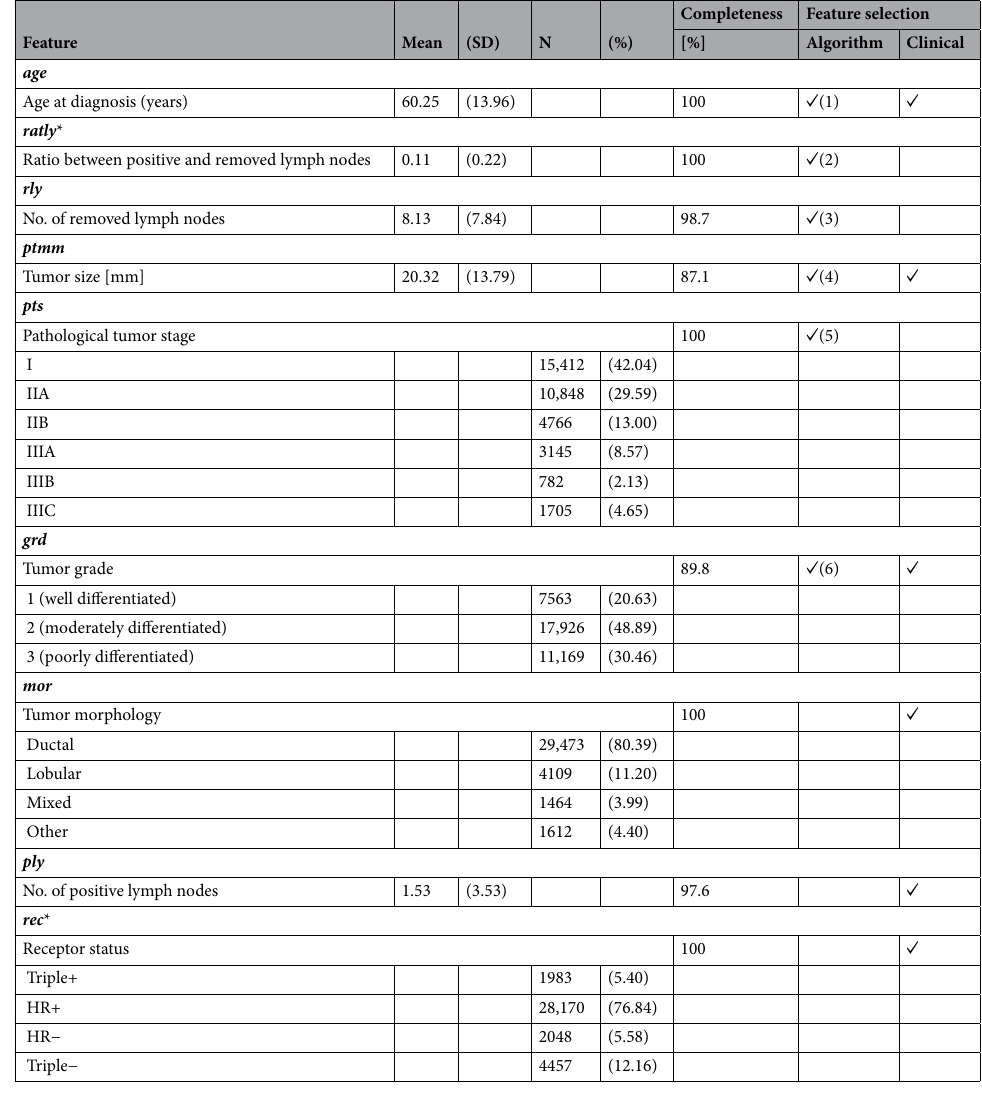
Table 1. General overview of the data used for this study. Features marked with an asterisk were engineered (see text for more details). The number in parenthesis in the Algorithm column corresponds to the feature’s ranking given by the feature selection. SD standard deviation, HR + hormone receptor positive, HR - hormone receptor